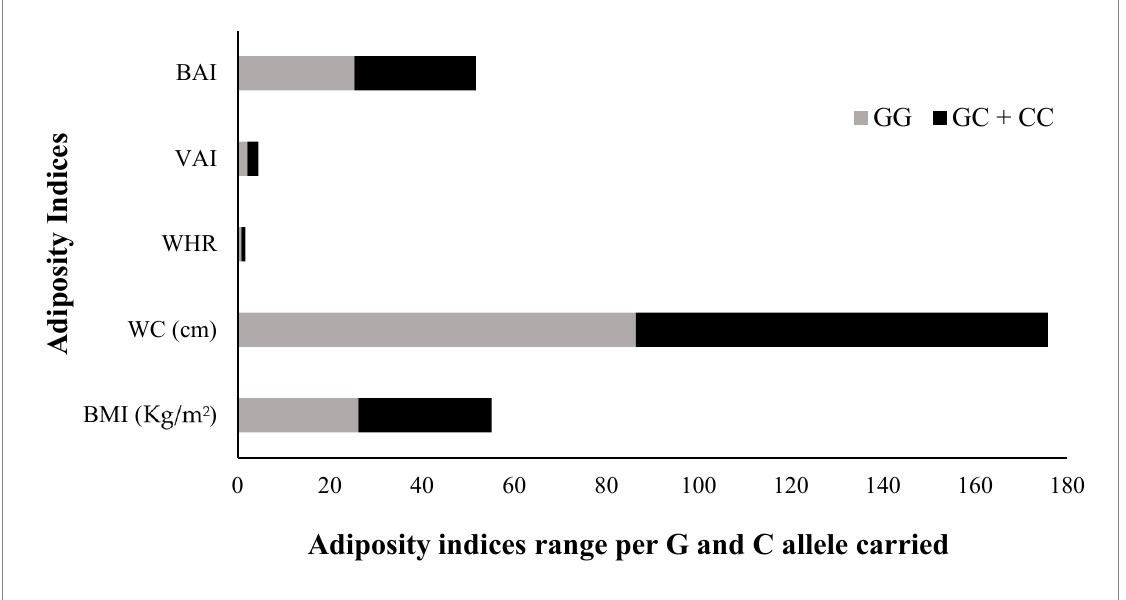
Figure 5. Comparison of adiposity indices in rs1333049 SNP minor/risk © allele and major (G) allele carriers. Comparison of the levels of all adiposity indices (BMI, body mass index; WC, waist circumference; WHR, waist-hip ratio; VAI, visceral adiposity index; and BAI, body adiposity index, among G allele carrier (GG homozygotes) and C allele carrier (GC heterozygotes and CC homozygotes combined) study subjects. All adiposity indices were raised in C allele carriers compared with G allele